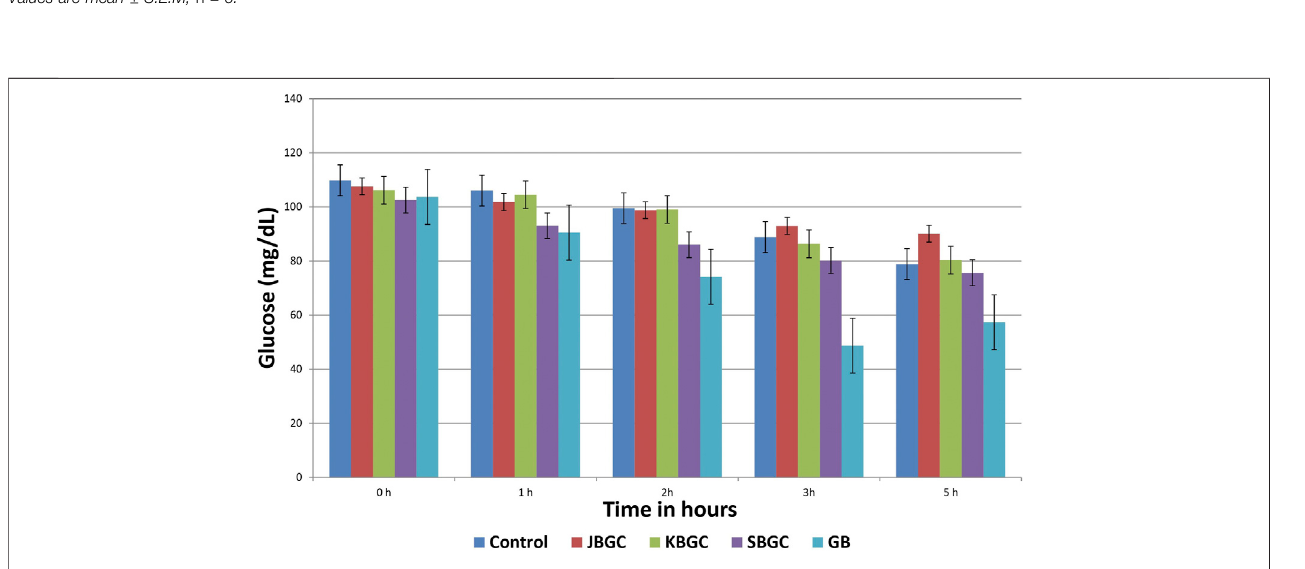
FIGURE 6 | Effect of Svarasa Bhavita Guduchi Churna (SBGC), Kwatha Bhavita Guduchi Churna (KBGC), and Jala Bhavita Guduchi Churna (JBGC) on BSL in normal fasted mice.